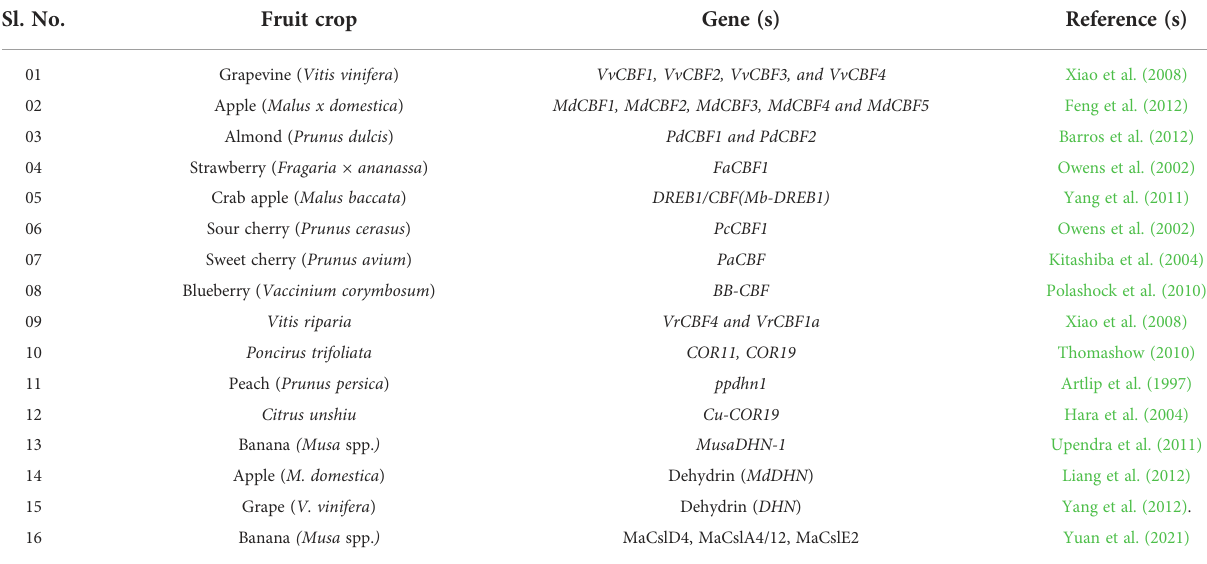
TABLE 2 Various gene (s) responsible for LTS tolerance in different fruit crops. Sl. No.